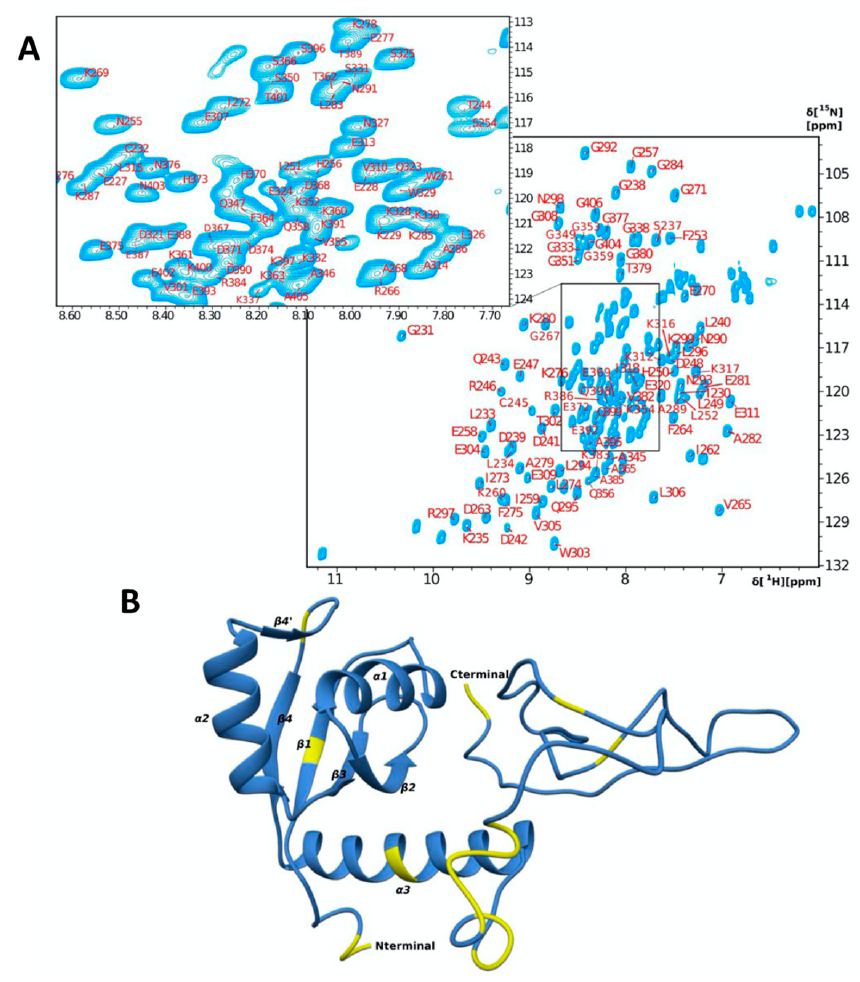
Figure 1. ( A ) 1 H- 15 N HSQC spectrum and assignment of human La RRM2-Cter; ( B ) chemical shift mapping of the unassigned residues’ NHs (yellow) of the CS Rosetta model of RRM2-Cter. The secondary structure of RRM2-Cter, produced by the TALOS+ server (Figure S1), shows that the RRM2 domain is structured, while the C-terminal region is unstructured. The topology of this polypeptide predicted by TALOS+ is β - α - β - β - α - β - β - α . Based on the chemical shifts difference of the C β and C γ of the prolines, all prolines (P348, P381 and P394) are in trans conformation